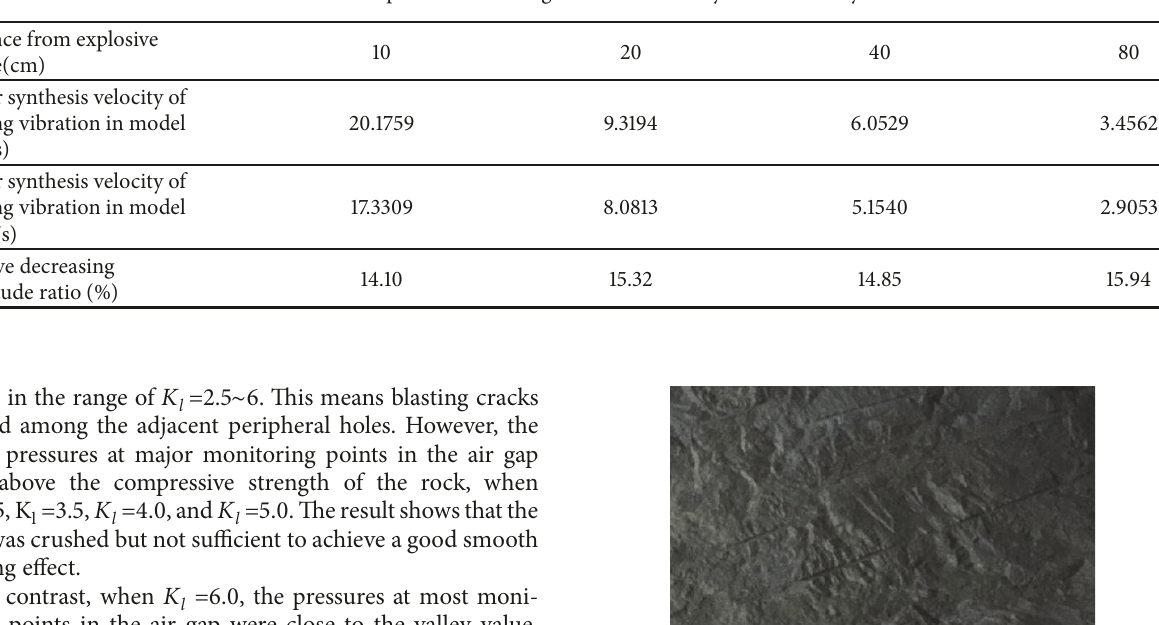
Table 9: Comparison of blasting vibration vector synthesis velocity.